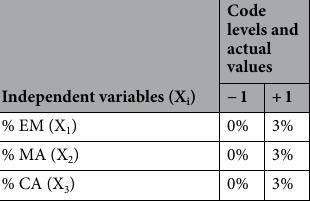
Table 1. Code levels and actual values of independent variables created according to the 2-level full factorial design (FFD); (%w/v).